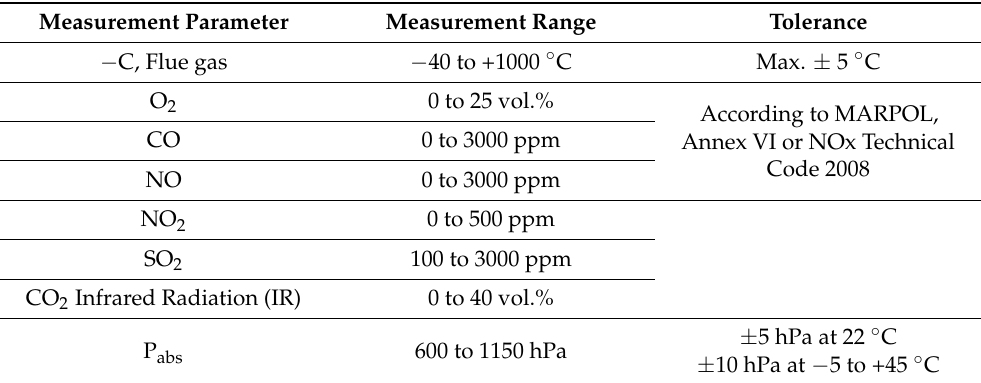
Table 4. Measuring ranges and accuracies of the measuring instrument. Measurement Parameter Measurement Range